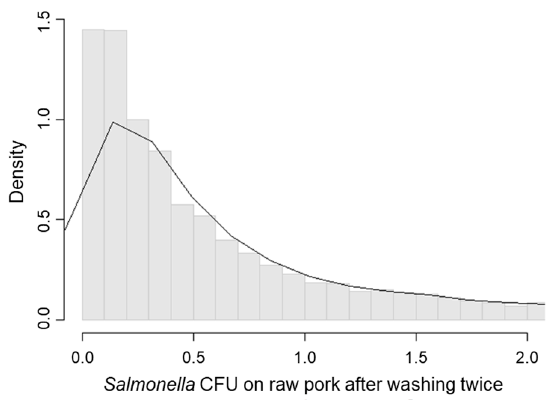
Figure 2. Distribution of Salmonella concentration (CFU/g) on raw pork after washing twice.